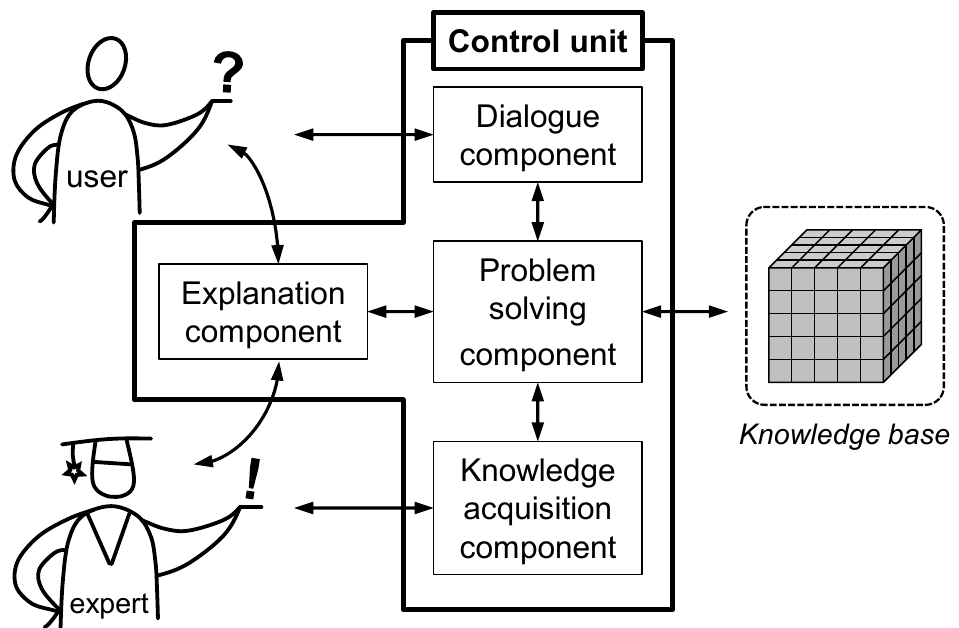
Figure 3. The general architecture of a knowledge based system and its interaction with user and